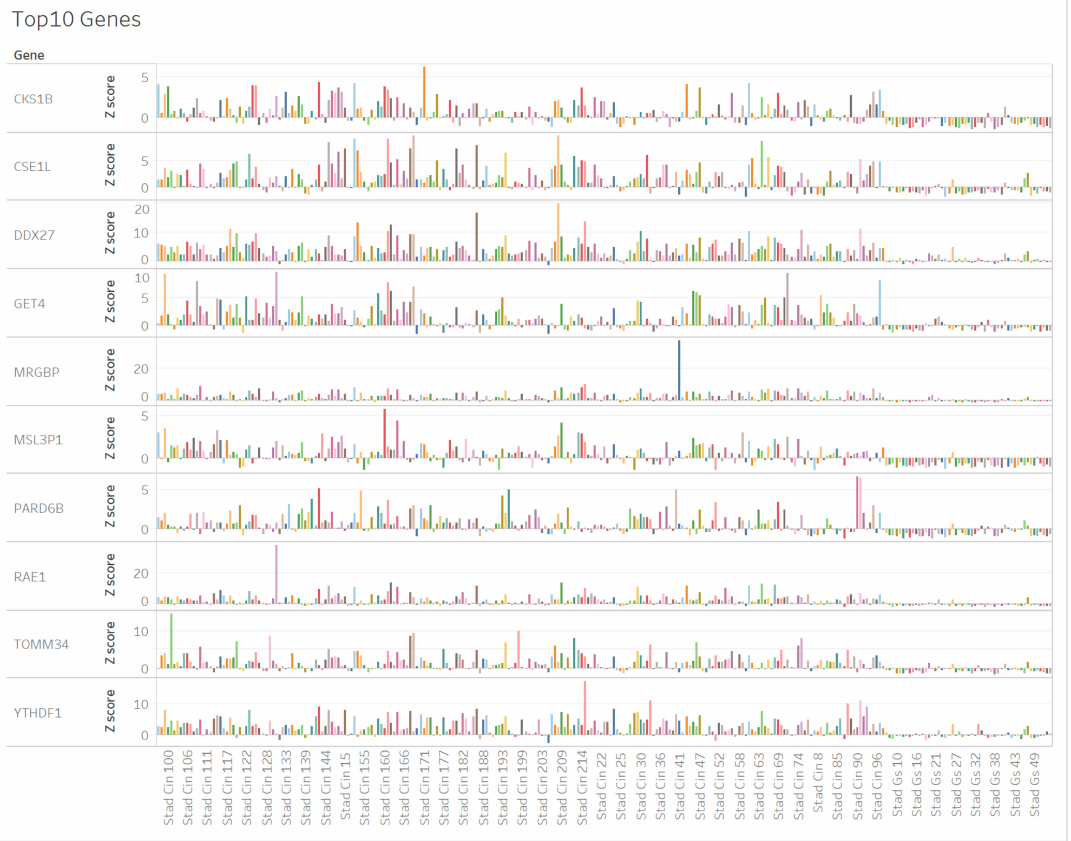
Figure 1. Gene expression profile of top 10 genes altered in intestinal- and di ff use-type gastric cancer (GC). The gene expression of top 10 genes, which have significant di ff erence between intestinal-type (CIN; chromosomal instability) and di ff use-type (GS; genomically stable) gastric cancer (GC) in The Cancer Genome Atlas (TCGA); RNAseq data are shown in Tableau